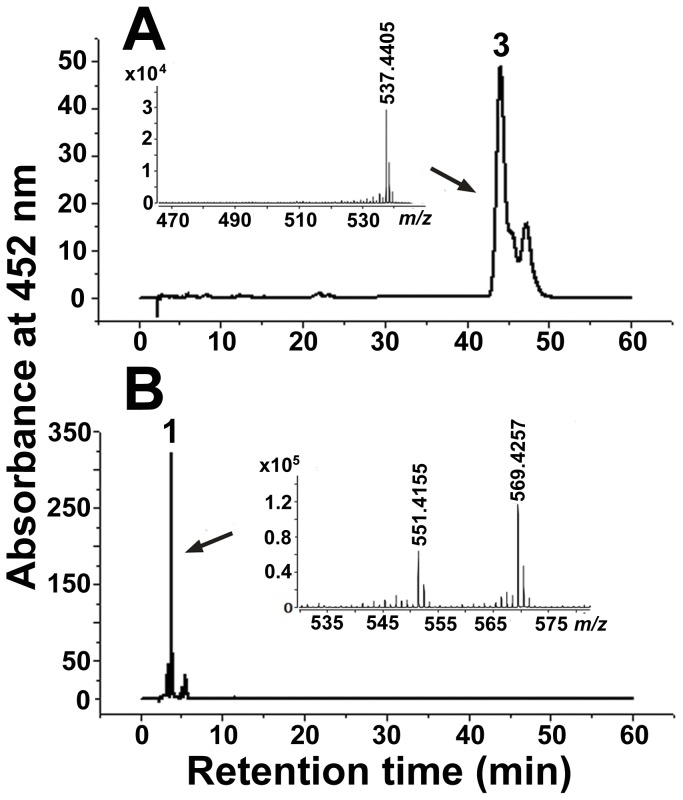
HPLC analysis and positive-ion APCI-MS spectra of the carotenoids accumulated in E. coli for the functional identification of crtZ (Detected at 452 nm).(A) E. coli containing pACCAR16ΔcrtX and pUC19. (B) E. coli containing pACCAR16ΔcrtX and pUcrtZ. Peak 1, zeaxanthin ([M+H]+ at m/z = 569.4257, and [M+H-H2O]+ at m/z = 551.4155). Peak 3, β-carotene ([M+H]+ at m/z = 537.4405).